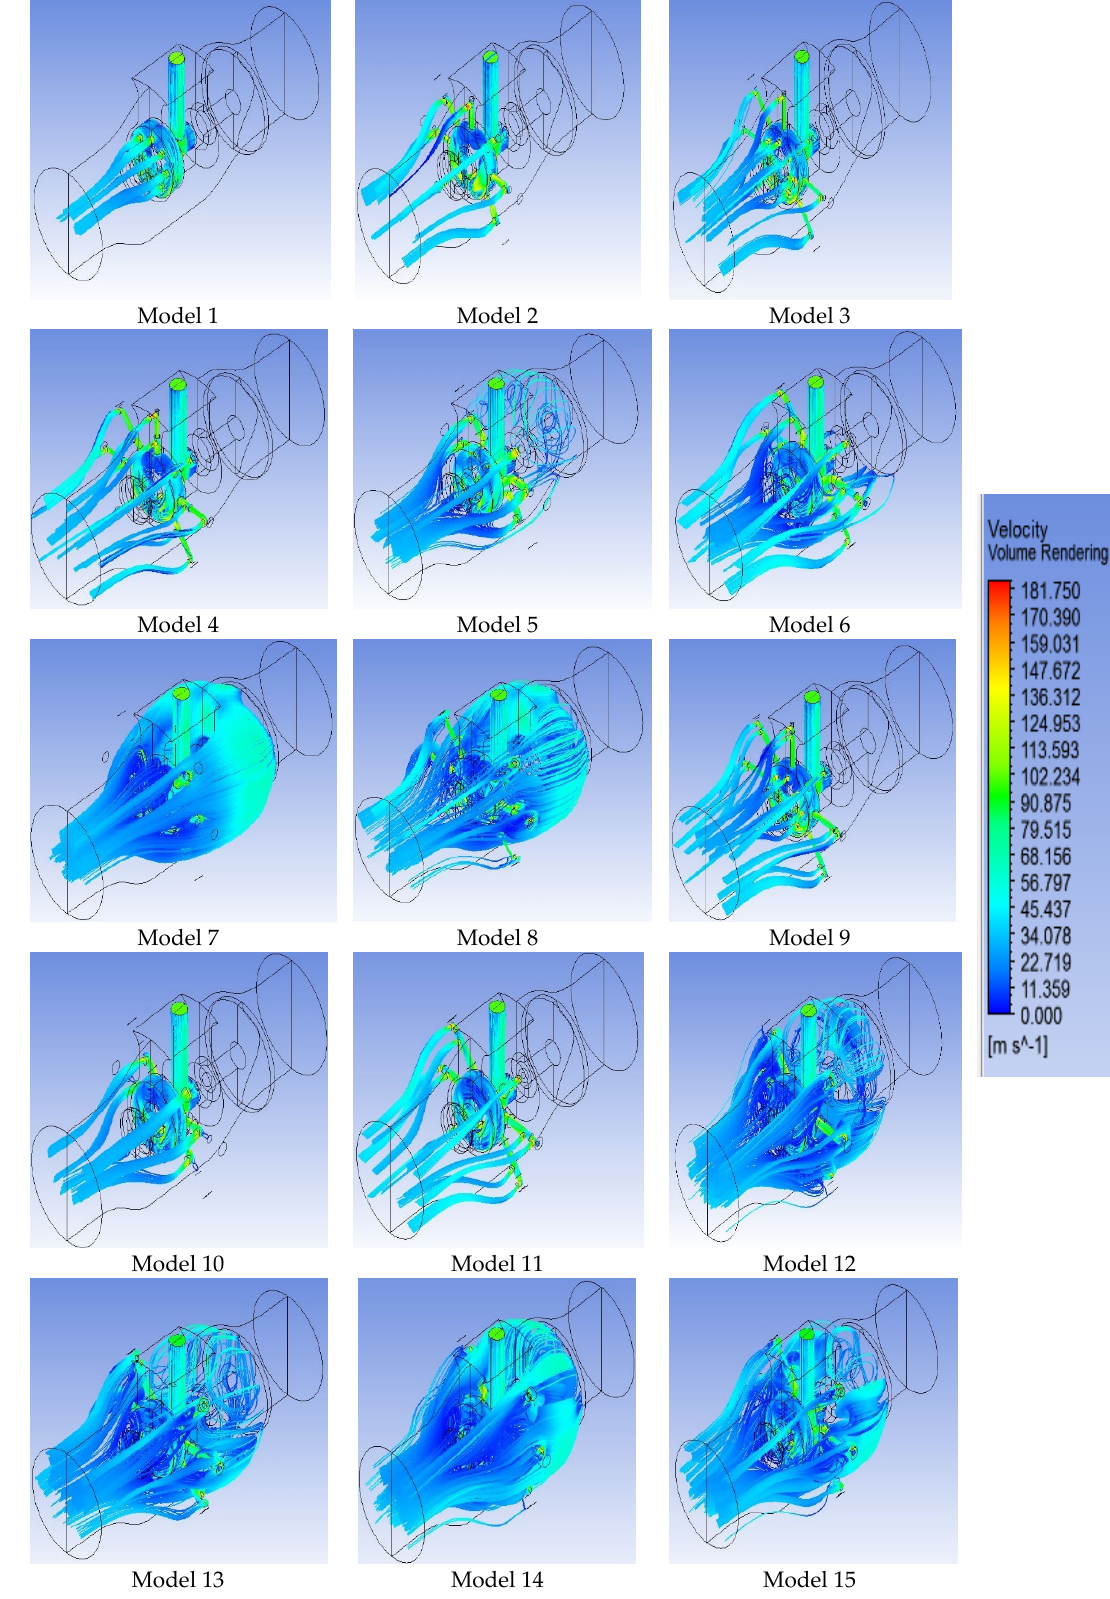
Figure 15. Velocity streamline (with 1000 points at HCNG inlet) for new mixer models under Air-HCNG ratio 51.315.